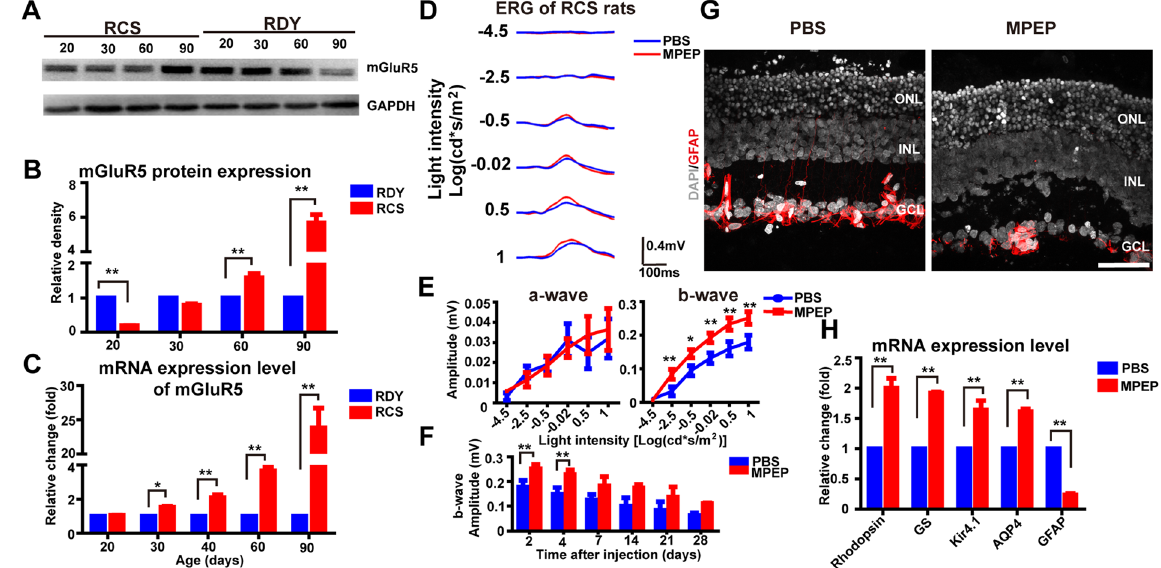
Figure 8. Inhibition of mGluR5 by subretinal injection of MPEP restored the ERG b-wave amplitude and decreased the expression of GFAP in RCS rats. ( A ) Representative western blotting of mGluR5 expression at P20, P30, P60 and P90 in RCS ( left ) and RDY ( right ) rats. ( B ) Quantification of mGluR5 protein expression in RCS rats ( red bars ) vs. RDY rats ( blue bars ) at P20, P30, P60 and P90 (n = 3 for each bar). ( C ) Quantified mGluR5 mRNA expression in RCS vs. RDY rats at P20, P30, P60 and P90 (n = 3 for each bar). ( D ) Example ERG waveforms recorded from MPEP-injected eyes ( red traces ) vs. PBS (control)-injected eyes ( blue ) of RCS rats (P35) at 4 days post-injection. ( E ) Left: Average stimulus-response curves for ERG a-wave amplitude in the MPEP-group ( red ) vs. PBS-group ( blue ) at increasing light intensities (n = 7 for each data point). Right: The same for b-wave amplitude. ( F ) Amplitude of b-wave (light intensity: 0.5 log(cd * m/s 2 )) following MPEP ( red ) and PBS ( blue ) injection at 2, 4, 7, 14, 21 and 28 days post-injection. ( G ) Example immunolabelling with GFAP ( red ) and DAPI ( gray ) in the retinas of a PBS-injected eye ( left ) and an MPEP-injected eye ( right ) at 4 days post-injection. Scale bar = 50 µ m ( H ) Quantified mRNA expression of rhodopsin, GS, K ir 4.1, AQP4 and GFAP in MPEP-injected eyes ( red ) and PBS-injected eyes ( blue ) at 4 days post-injection (n = 3 per bar). Bar and line graph data show mean ± SEM. * p < 0.05, ** p < 0.01. GCL, ganglion cell layer; INL, inner nuclear layer; ONL, outer nuclear